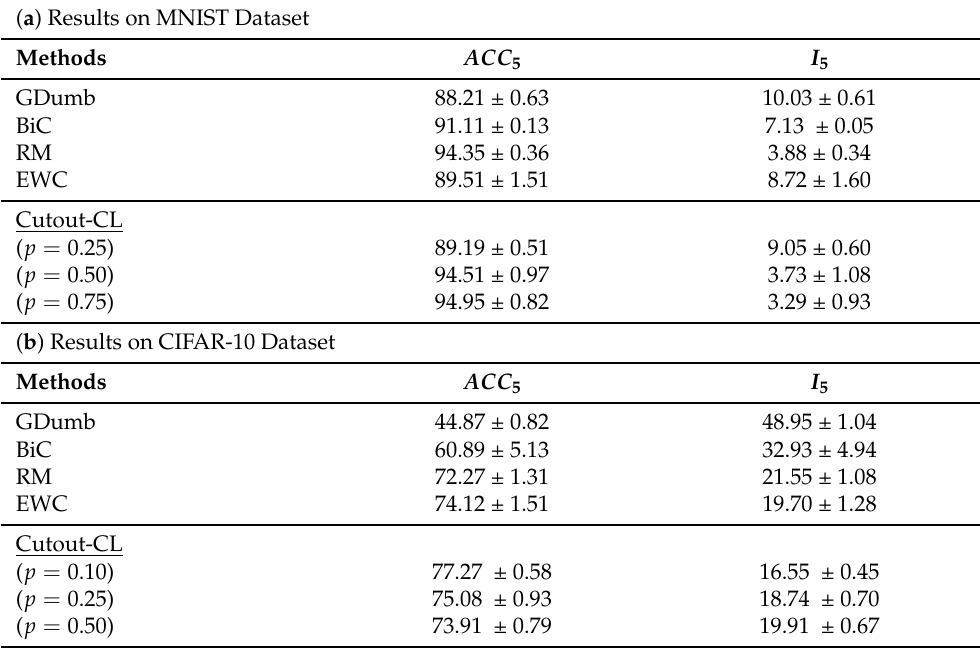
Table 4. Last accuracies on ( a ) MNIST and ( b ) CIFAR-10